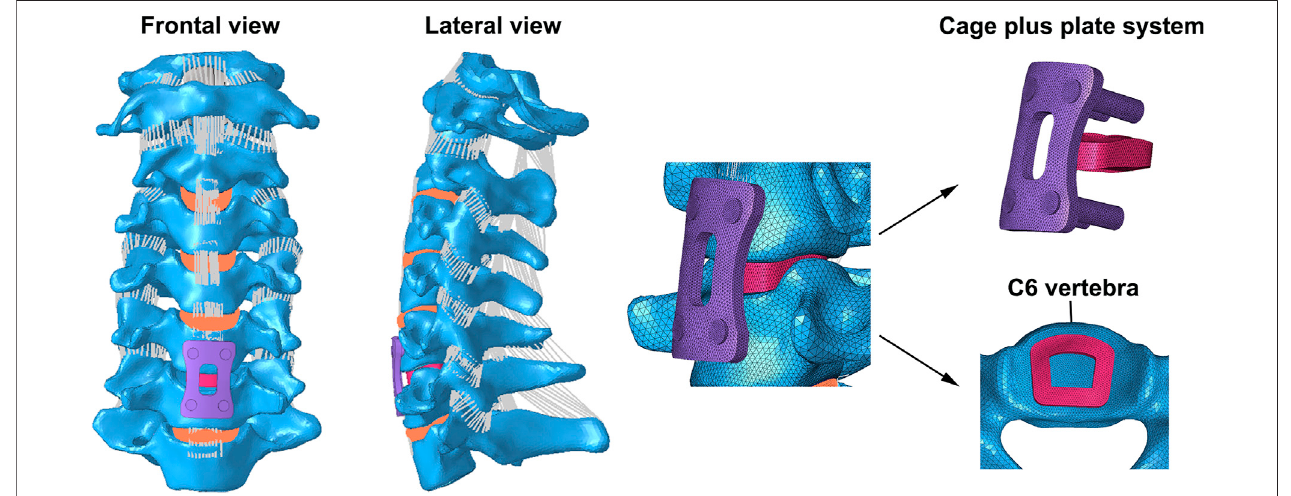
FIGURE 2 | FE model of single-level C5/6 ACDF implanted with a cage plus plate system was shown.